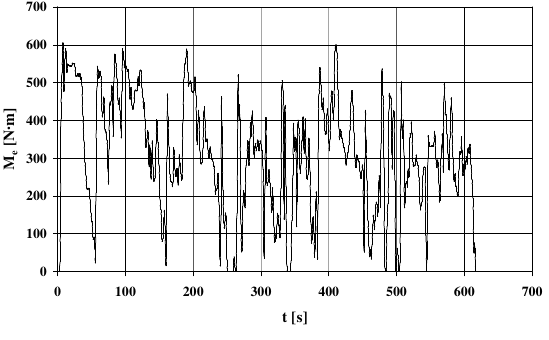
Fig. 7. The set of engine operational states: engine speed – n, torque – M e in the NRTC test; (AV[n], AV[M e ]) – the coordinates of the average values of the engine speed and engine torque